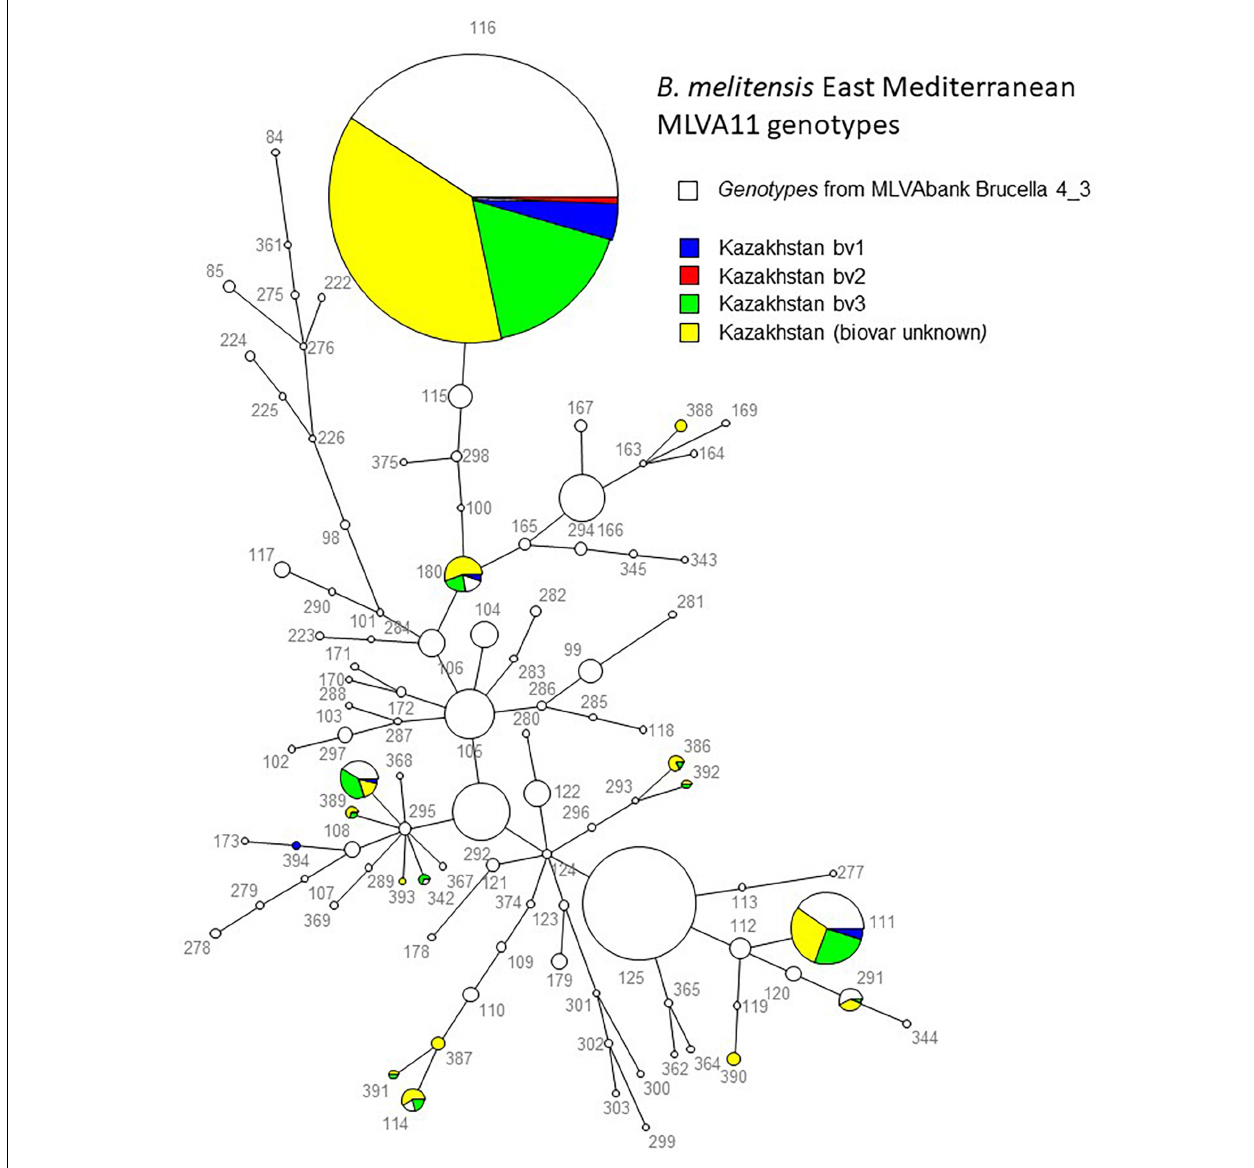
FIGURE 1 | MLVA11 in 2900 East Mediterranean B. melitensis entries including 1580 from Brucella MLVAbank version 4.3. The 1327 strains from the present study are colored. The biovar assignment is indicated when known. The numbers are the MLVA11 genotypes. The genotypes are connected by branches with a length of one or two corresponding to the categorical distance between